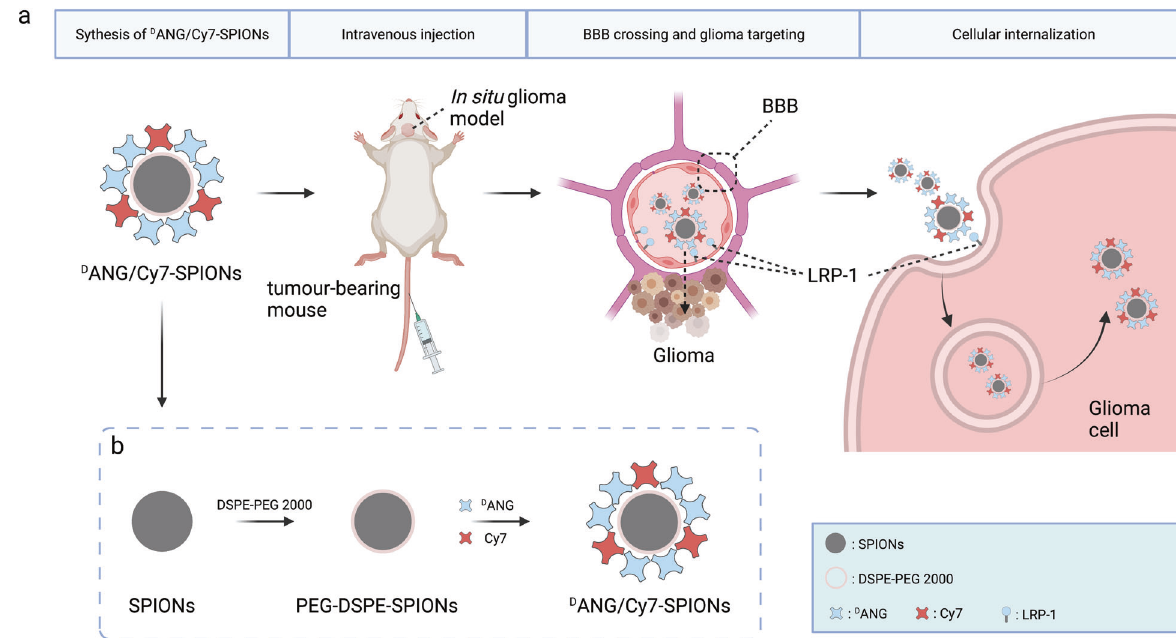
Fig. 1 a Schematic illustration of the construction and function of D ANG/Cy7-SPIONs, including their mechanism of crossing the BBB and targeting glioma cells and b their synthesis